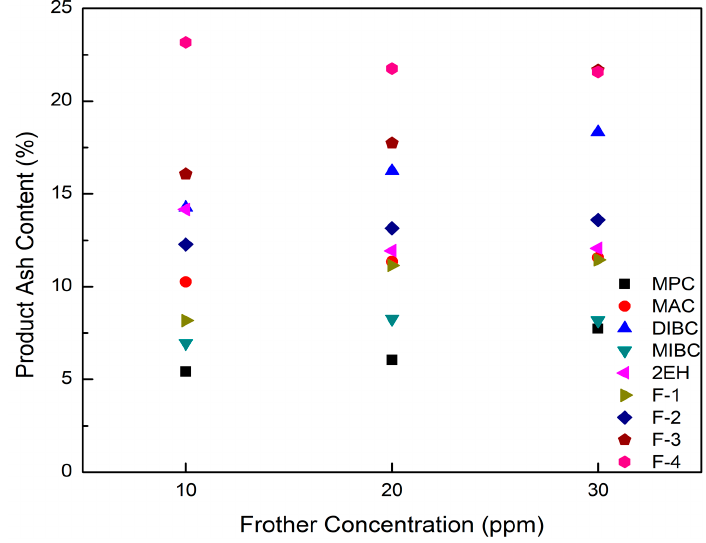
Figure 8. Product ash content as a function of frother concentration for each frother type.